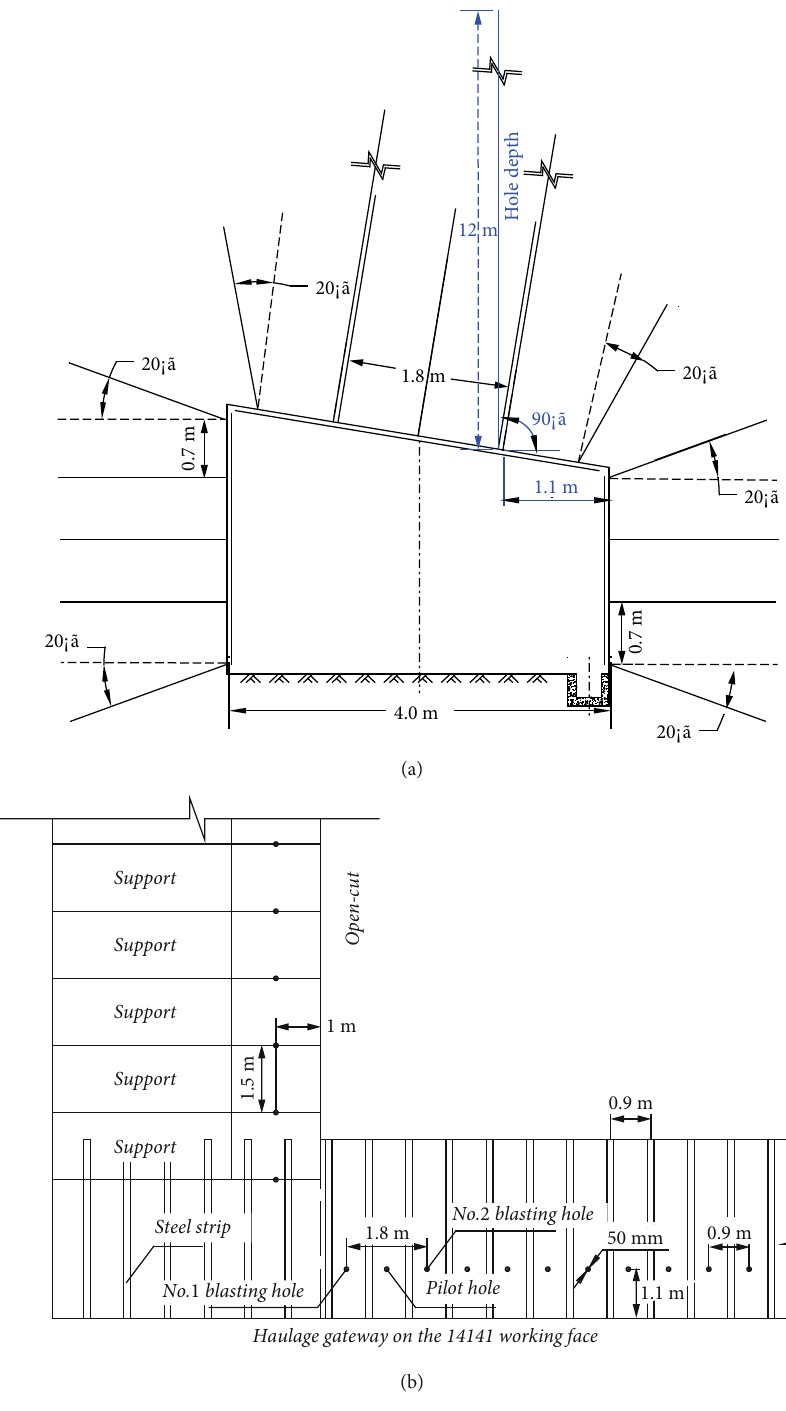
Figure 3: Layout of blasting holes in haulage gateway of the 14141 longwall